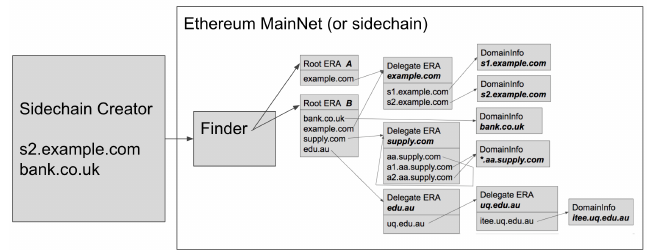
Figure 3: Finder Contract Resolving